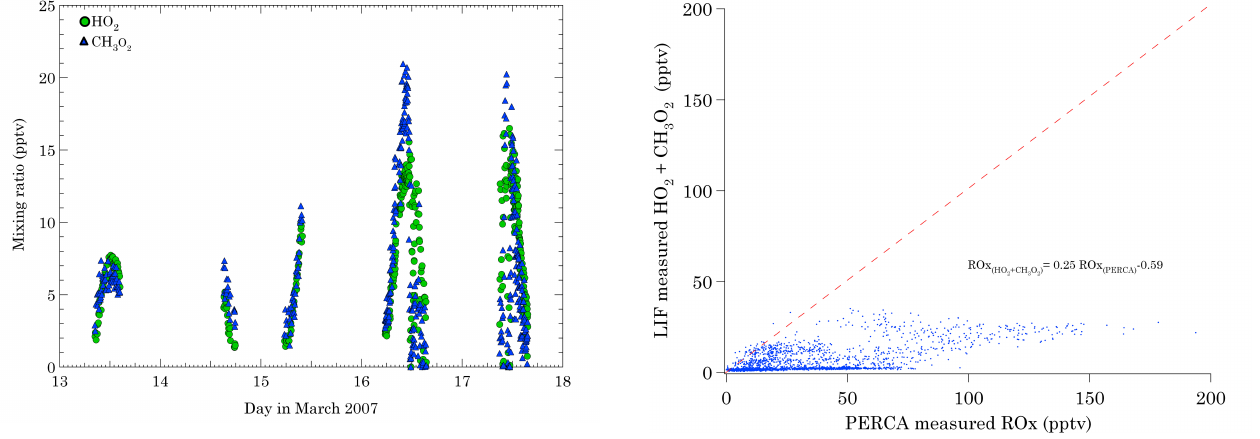
Fig. 12. PERCA measured RO x vs. RO x based on LIF measured HO 2 and an estimate of CH 3 O 2 (assuming RO 2 =CH 3 O 2 and that CH 3 O 2 ∼ HO 2 ) . The red dashed line illustrates the 1:1 line.